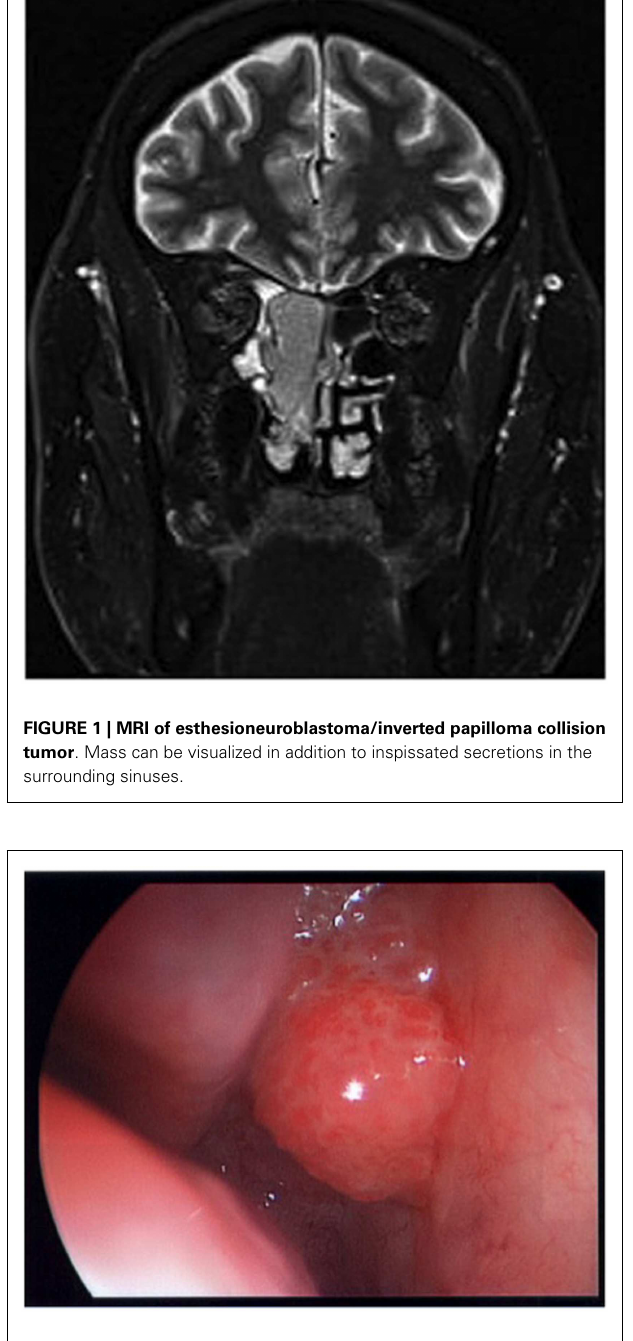
FIGURE 2 | Nasal endoscopy view of collision tumor. andbiopsyrevealedahigh-grademalignantneoplasmadjacenttoa sinonasal papilloma with focal inverted growth pattern ( Figure 3 ). The tissue was negative for Epstein–Barr virus nuclear antigen-1